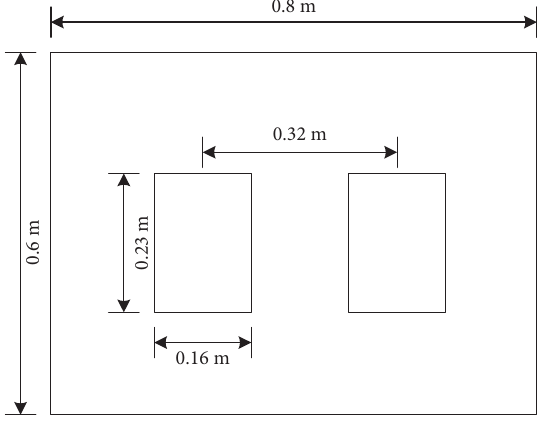
Figure 3: Layout of rectangular loading.